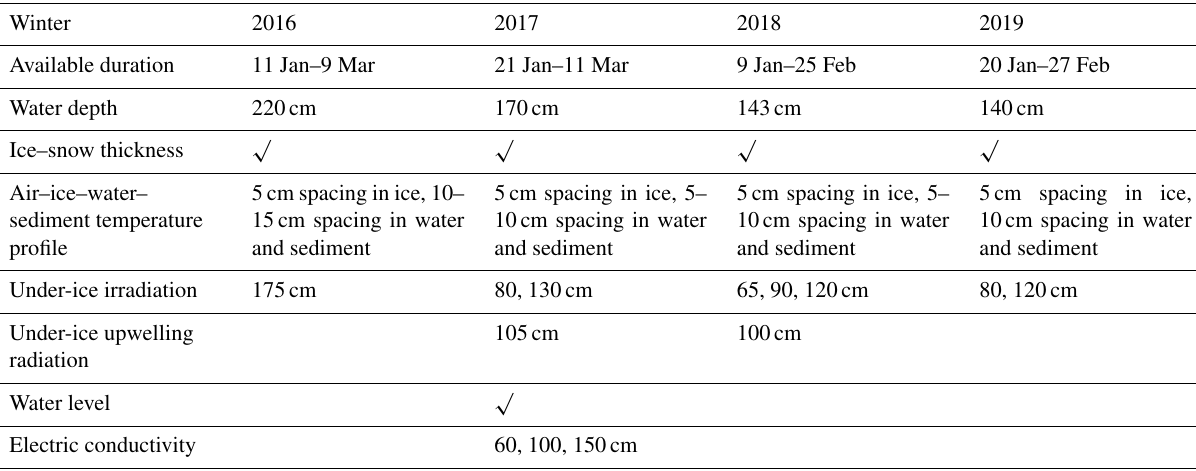
Table 1. Data series acquired during the four-winter observation program.